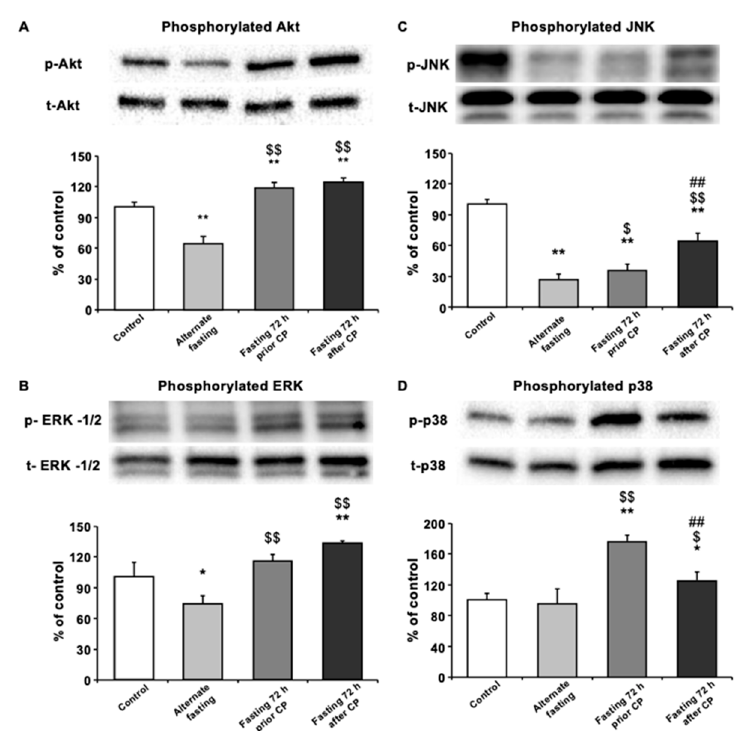
Figure 3. Seventy-two-hour fasting rescues kidney morphology and function through MAPK pathway. Western blot analysis of pooled tissue samples. Changes in protein levels of ( A ) p-JNK, ( B ) p-AKT, ( C ) p-ERK-1/-2 and ( D ) p-p38. * p < 0.05, ** p < 0.01 compared with control; $ p < 0.5, $$ p < 0.01 compared with alternate fasting; # p < 0.05, ## p < 0.01 compared with 72 h before.